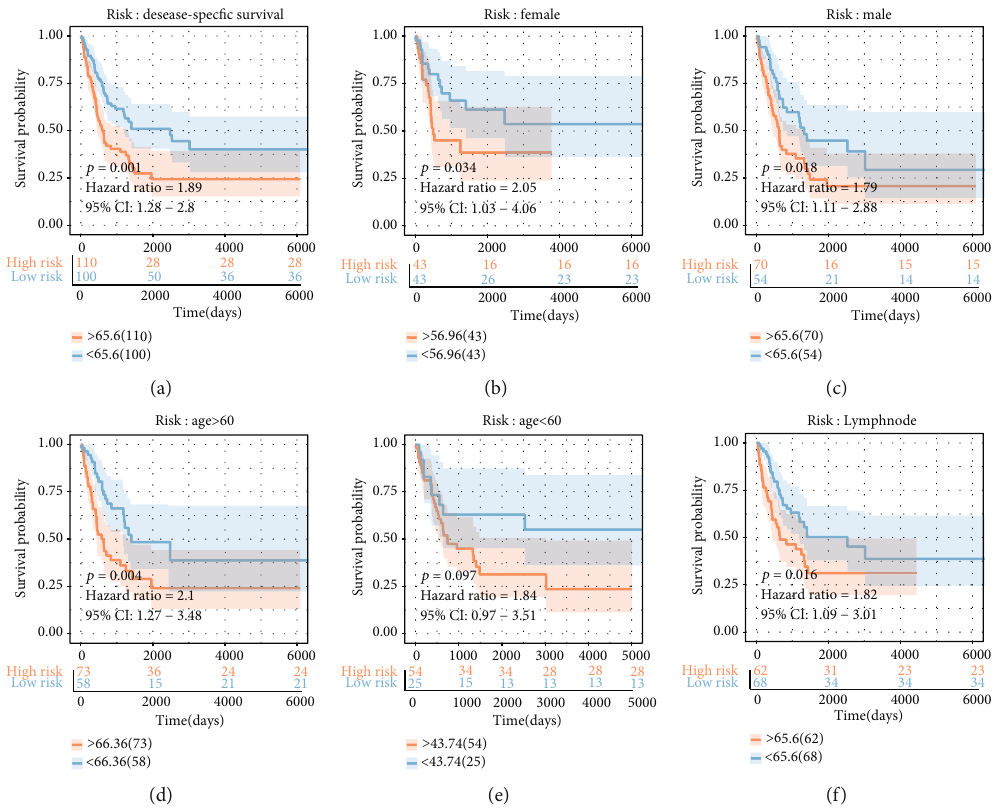
Figure 5: (a) Validation test and (b – f) subgroup evaluation of the GSE65904